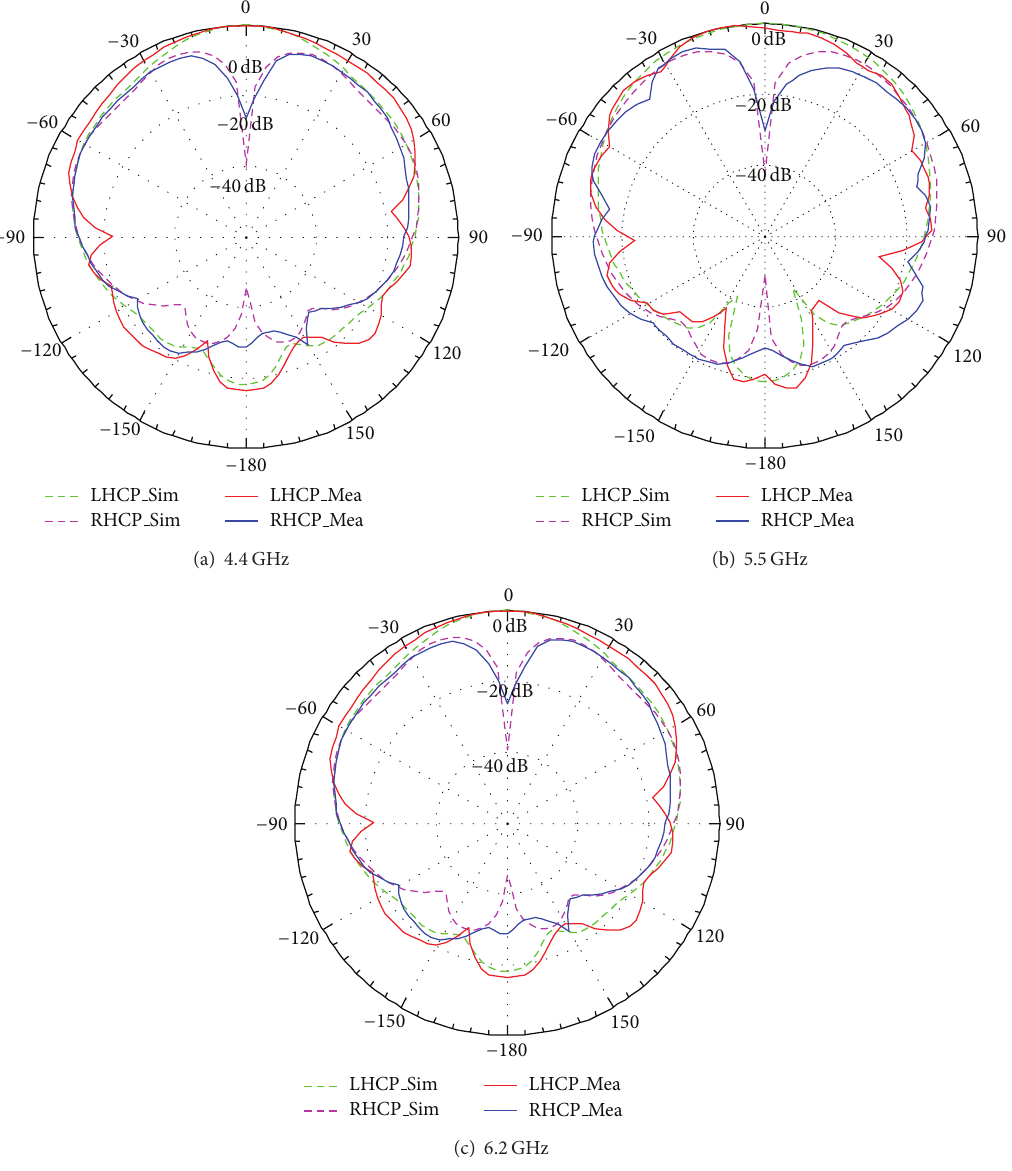
Figure 14: Simulated and measured radiation patterns of the antenna at 4.4 GHz, 5.5 GHz, and 6.2 GHz in the 𝑥𝑦 -planes.